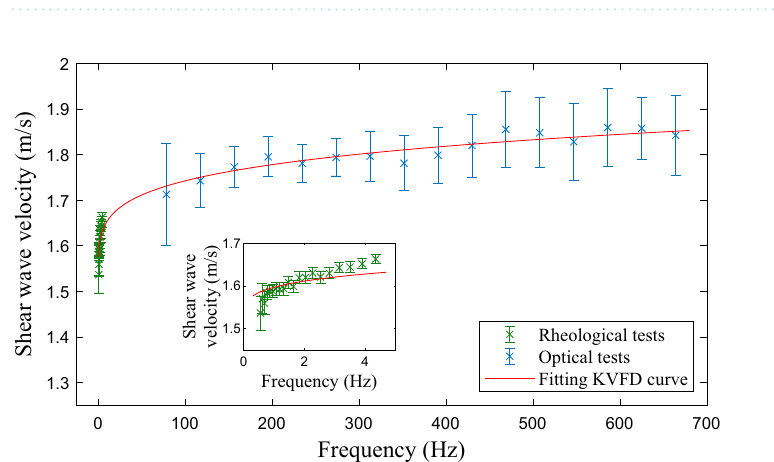
Figure 11. Shear wave velocity dispersion curve over frequency for the background material of the phantoms by combining results from the rheometry tests (in green) and from the HSC tests (in blue). The red curve is the result of fitting the data by the theoretical KVFD expression for shear wave velocity. Results are shown in terms of mean and standard deviation values after combining results from the three